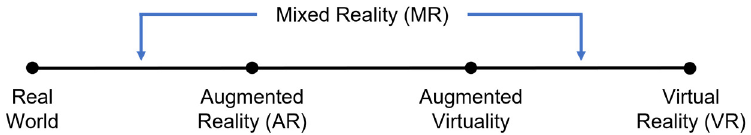
Figure 1. Extended reality and virtual continuum Redrawn from [110].